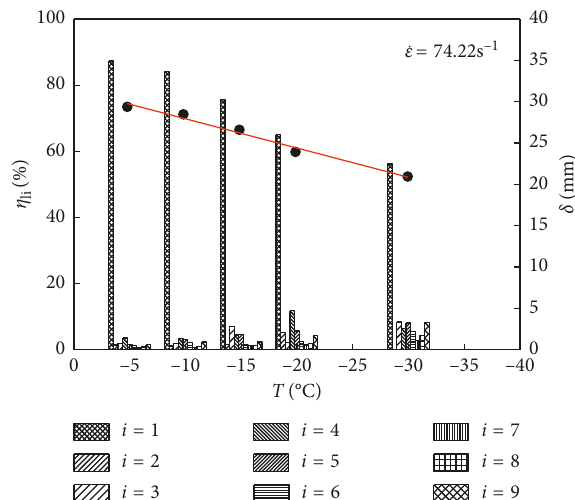
Figure 7: Distribution of yellow sandstone fragments at different freeze-thaw